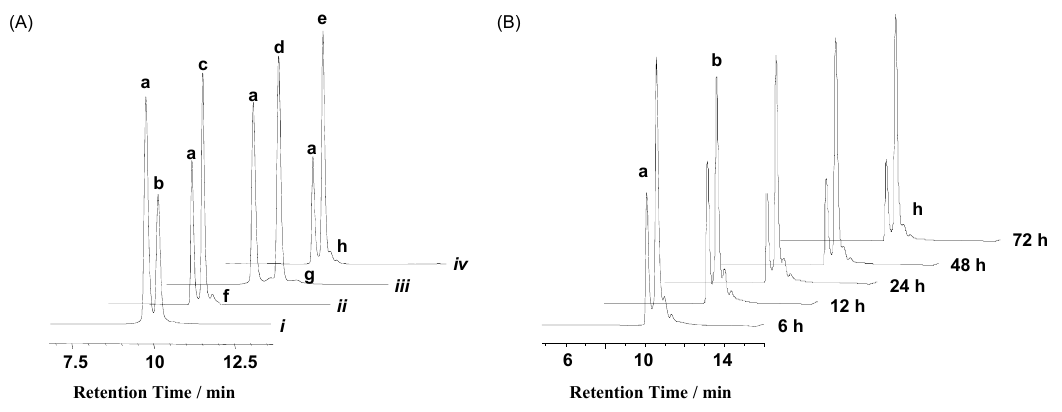
Figure 1. High performance liquid chromatography (HPLC) chromatograms with ultraviolet (UV) detection at 260 nm for reactions of ruthenium complexes with single strand I . ( A ) Complex 1 ( i ), 2 ( ii ), 3 ( iii ), or 4 ( iv ) with single strand I (0.1 mM, Ru/ I = 1.0) in 50 mM triethylammonium acetate buffer (TEAA) (pH 7) at 310 K for 24 h; ( B ) complex 1 with I (0.1 mM, Ru/ I = 1.0) in 50 mM TEAA (pH 7) and 5 mM NaCl at 310 K for different times. Peak assignments: a, unruthenated strand I ; b, c, d, and e, mono-ruthenated I ; f, g, and h, di-ruthenated I . For mass spectra, see Figure S1 in Supplementary Materials.